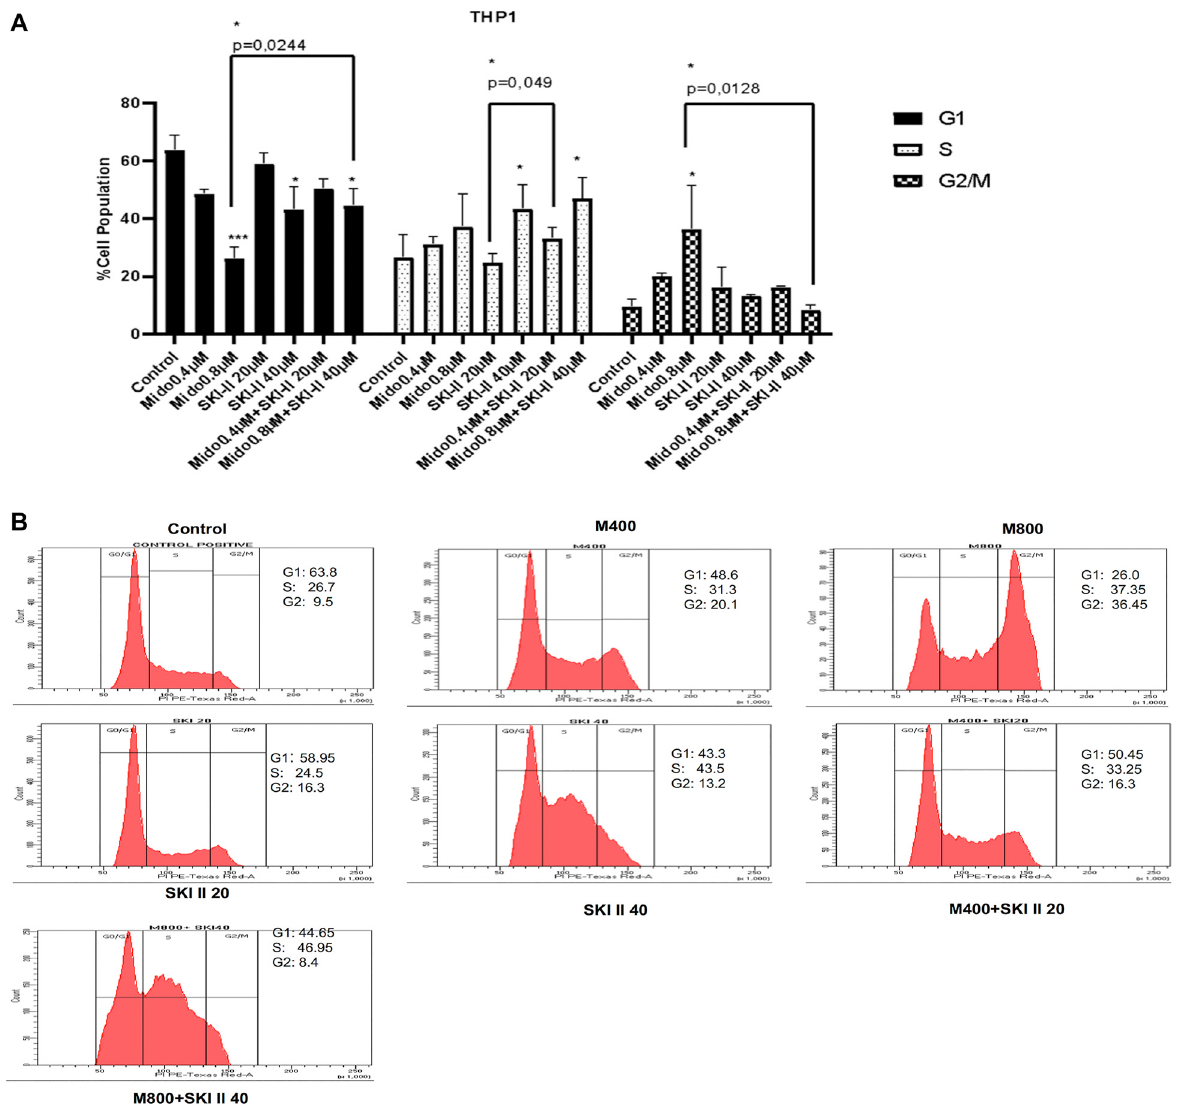
Figure3: CellcycleprofilesofTHP1cellsaftermidostaurin,SKIIIandcombinationtreatmentsfor48h.Dataareshownasthemeans ± SDofat least two independent experiments. *p<0.05, ***p<0.0001 vs.